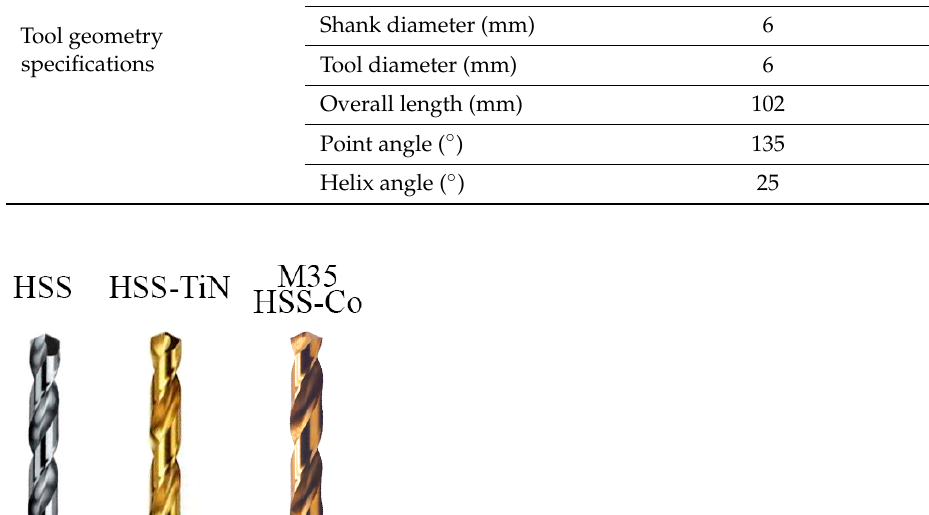
Table 2. Parameter details in drilling fly ash geopolymer.